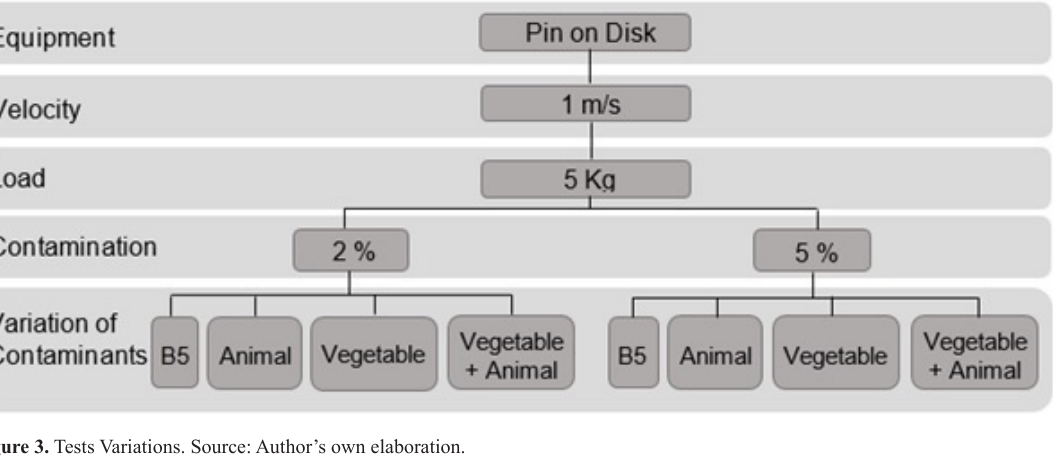
Figure 3. Tests Variations. Source: Author’s own elaboration.